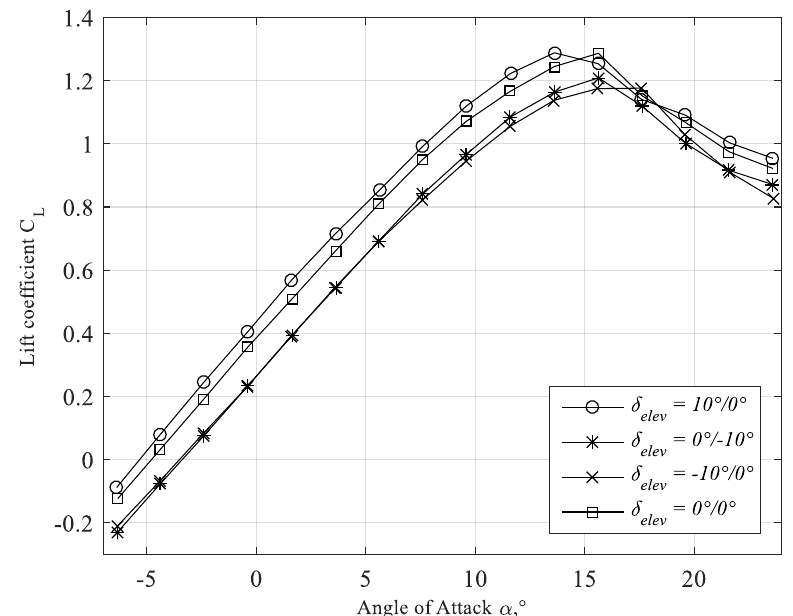
Figure 15 . Tuft patterns over the fore right elevator at various deflection angles .